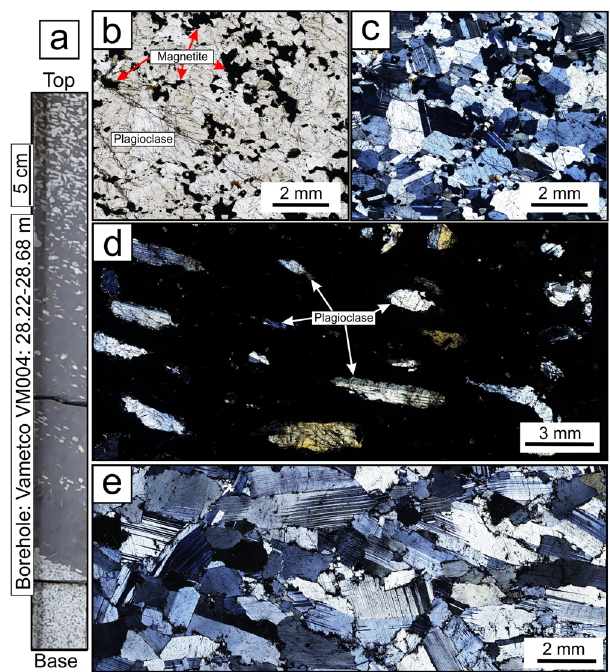
Fig. 3 Appearance of magnetitite and adjacent lithologies. a A relatively thin magnetitite layer sampled in drill core from the Vametco mine in the Western Limb. The layer shows characteristics that are common to most magnetitite layers of the Bushveld Complex. These include a light-colored anorthositic footwall, a dark gray magnetitite layer with a sharp and perfectly massive base with sporadic occurrences of moderate to well- foliated plagioclase primocrysts (light in color) further upwards, and an upper gradation into a plagioclase-rich layer. b Photomicrograph of the overlying magnetite – anorthosite in plane-polarized and ( c ) crossed polars. The grain size of plagioclase varies substantially, they tend to be mostly equant to occasionally tabular in shape, and a foliation appears weak or absent. d Photomicrograph of the upper gradational contact of a magnetitite layer shown in Fig. 5b. Plagioclase grains, surrounded by Fe-Ti oxides, are tabular with irregular boundaries. A well-developed foliation can be observed, while the sub-parallel orientation of albite twins hint at a crystal-preferred orientation (crossed polars). e Photomicrograph of the footwall anorthosite. Plagioclase grain size is variable, grain contacts are planar to irregular, with indications of deformation. All thin sections are oriented perpendicular to the igneous